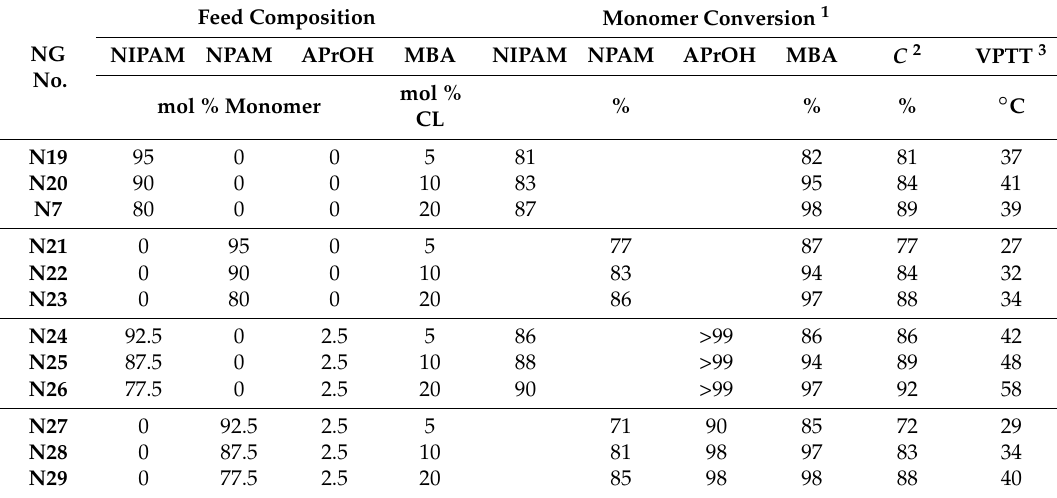
Table 1. Monomer conversions and volume phase transition temperatures (VPTTs) for nanogels (NGs) N7 , N19 – N29 .